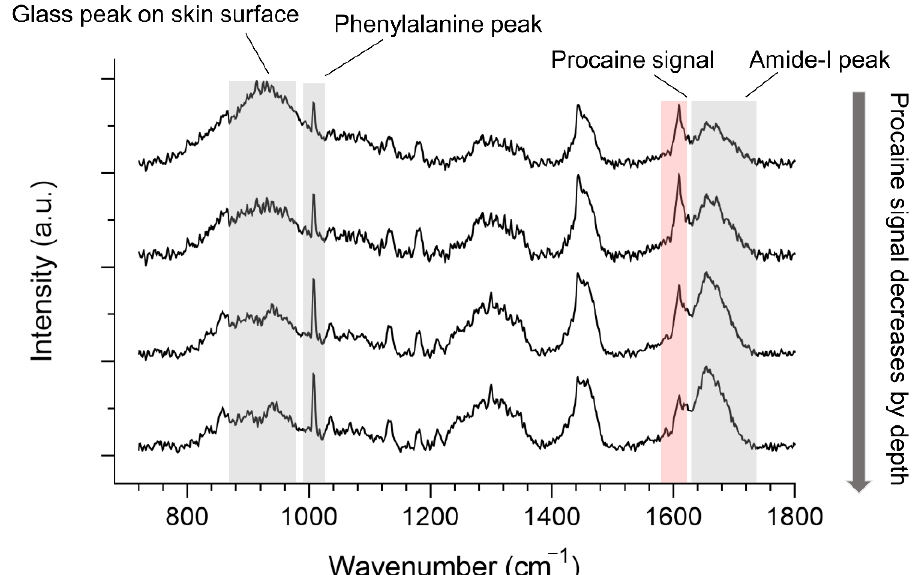
Figure 2. Typical spectra in off-line skin analysis of procaine signal decreasing by depth with crucial spectral features highlighted in colors.